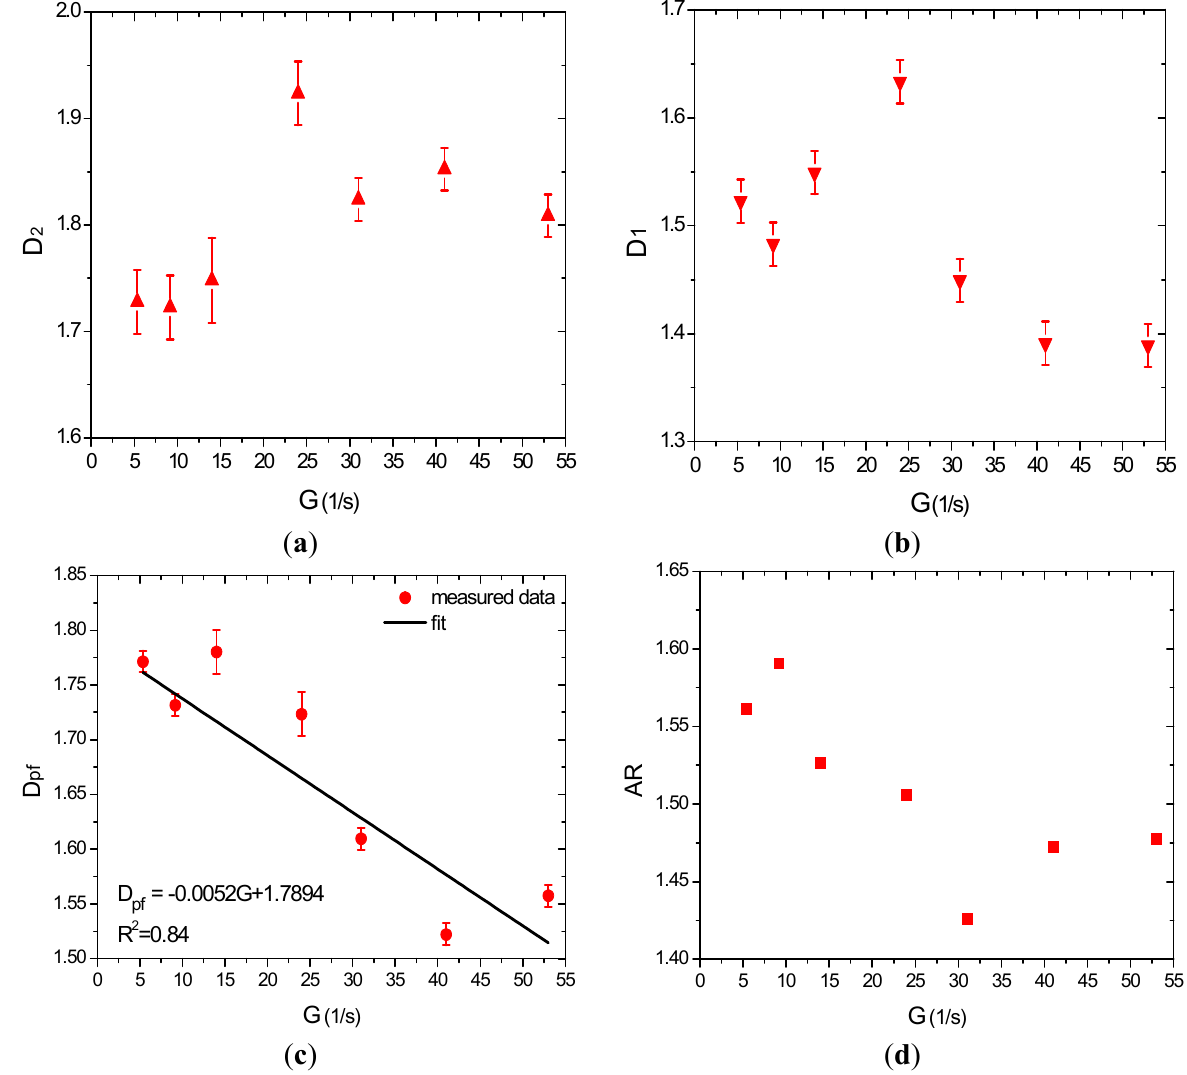
Figure 5. Morphological property parameters of the flocs at steady state with respect to different shear rates at φ = 7.87 × 10 − 5 without electrolyte added into the suspension, including 2-D fractal dimension ( a ); 1-D fractal dimension ( b ); perimeter-based fractal dimension ( c ) and aspect ratio ( d ). The error bars in (a–c) show standard deviations of D 2 , D 1 , and D pf values,